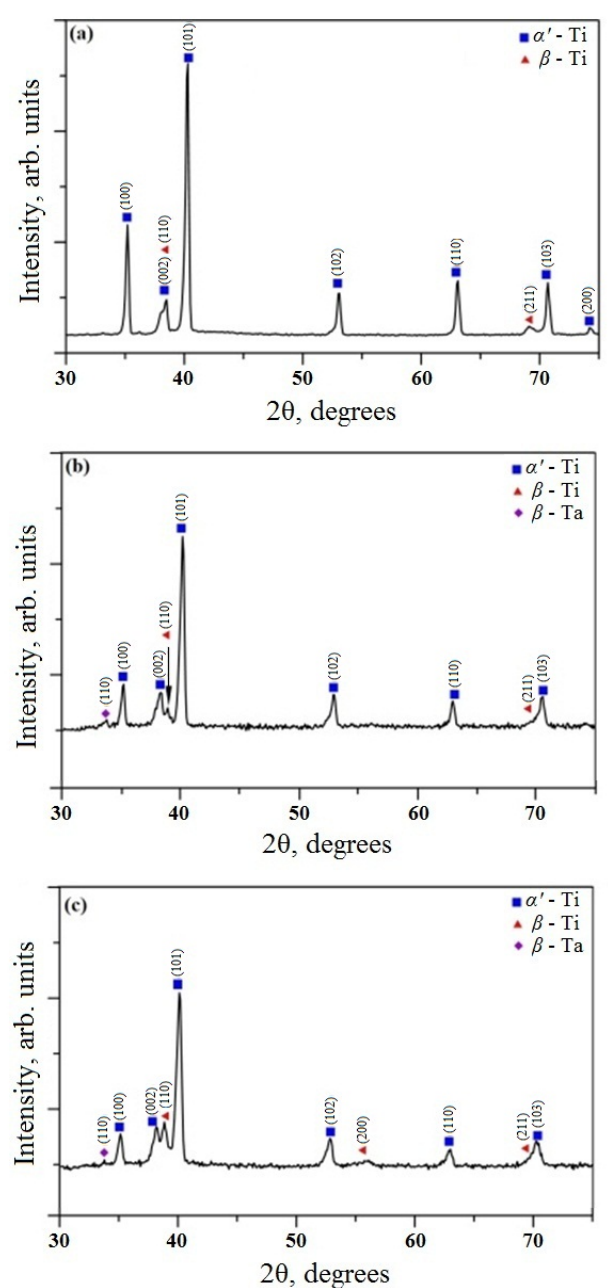
Figure 4. X-ray diffraction patterns of the specimens obtained after the ( a ) first cycle; ( b ) second cycle; and ( c ) third cycle.